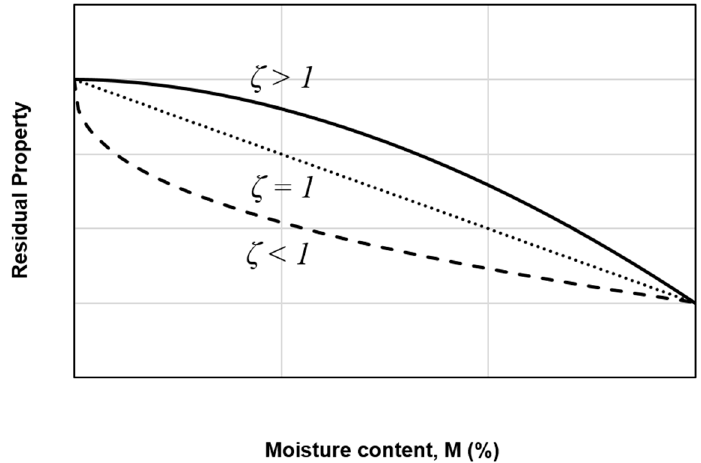
Figure 7. Three possible degradation trends of the residual property with respect to the moisture content.